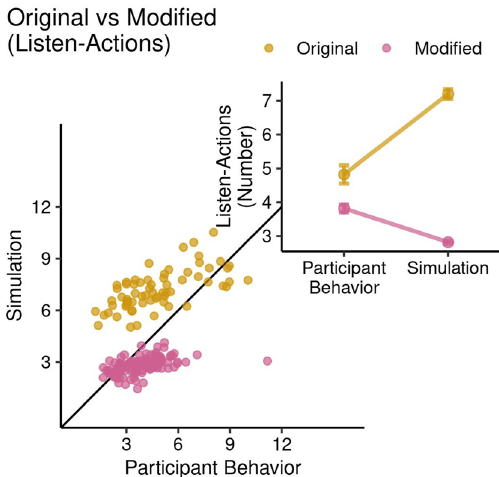
Figure 6. Comparison of actual and optimal number of listen action in the single-agent TT. Each dot represents a participant characterized by their actual (x-axis) and optimal (y-axis) number of listen actions averaged across all tiger trials. Whereas the optimal POMDP Level 1 model overestimates the number of listen action for the original payout matrix, it underestimates L actions for the modified payout matrix. In figure inset, we see main effects of the type of matrix, the participant behavior/simulation, and the interaction effect between them.